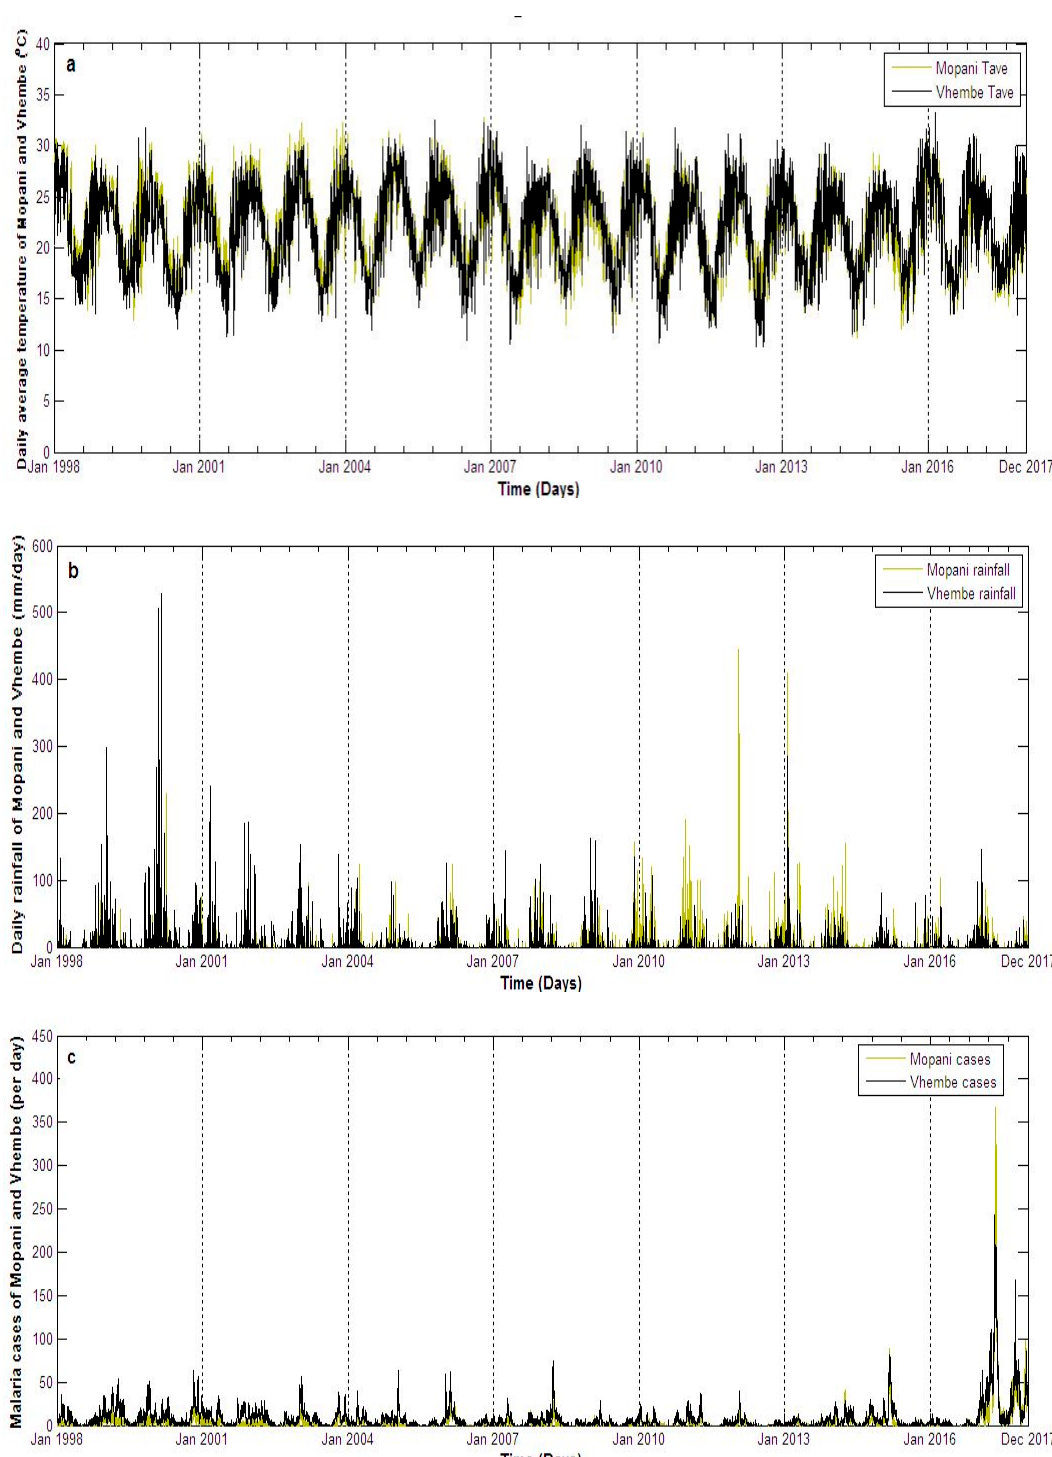
Figure 3. Time series of daily climate variables and malaria cases over calibration period comparing the ( a ) daily average temperature, ( b ) rainfall and ( c ) malaria cases of Mopani and Vhembe district municipality, Limpopo province, South Africa from January 1998 to December 2017.